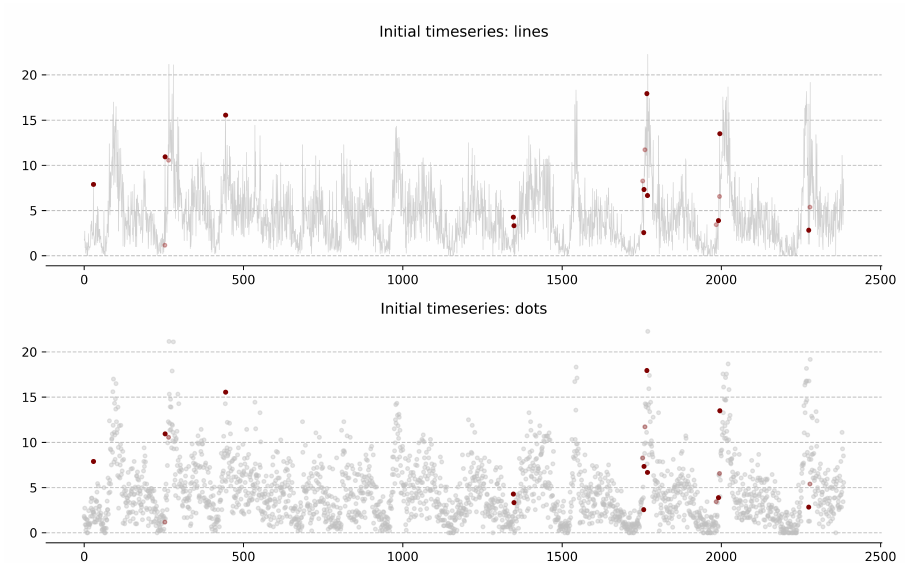
Figure 18. Numenta Anomaly Benchmark time series with both point and context anomalies (anoma- lies found with anomaly likelihood threshold 0.9).